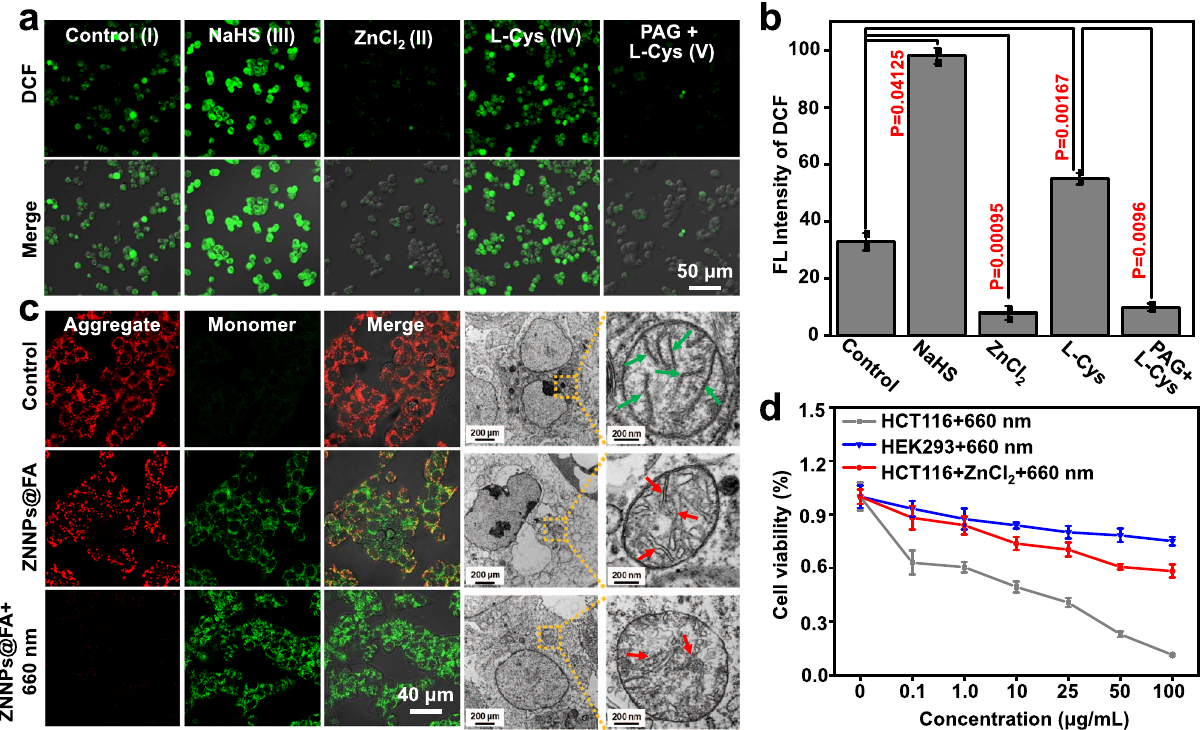
Fig. 7 H 2 S-activated PDT effect of ZNNPs@FA in HCT116 cells. a Confocal fl uorescence imaging and b quanti fi cation of H 2 S-activated ZNNPs@FA enabling 1 O 2 generation in HCT116 cells pretreated with PBS buffer, ZnCl 2 (40 μ g/mL, 10 min), NaHS (1 mM, 1 h), L-Cys (24 μ g/mL, 1 h), PAG (50 μ g/mL, 0.5 h) + L-Cys (24 μ g/mL, 1 h), LPS (1 μ g/mL, 6 h) + L-Cys (24 μ g/mL, 1 h), or PAG (50 μ g/mL, 0.5 h) + LPS (1 μ g/mL, 6 h) + L-Cys (24 μ g/mL, 1 h) upon 660 nm laser irradiation (50 mW/cm 2 , 3 min) using DCF-DA kit. c Mitochondrial membrane potential of cells treated with PBS buffer, ZNNPs@FA (12